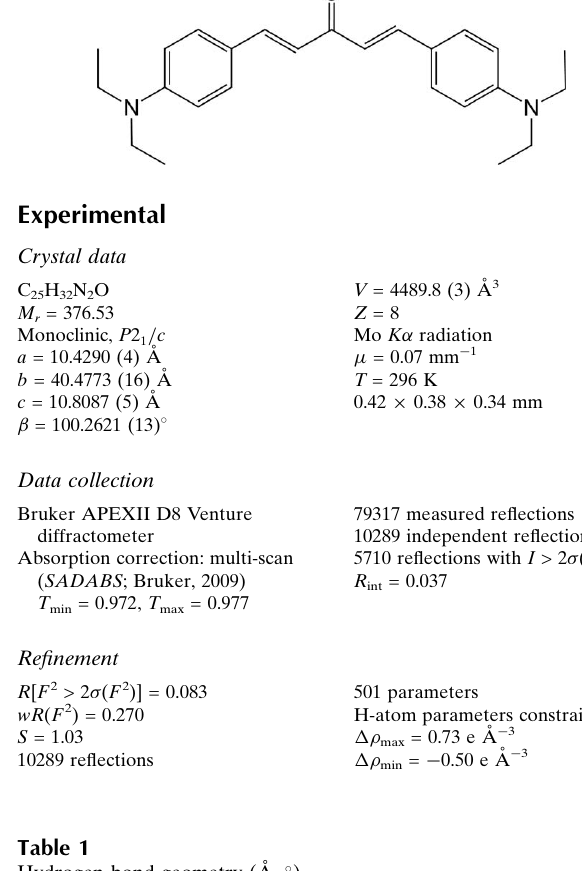
Hydrogen-bond geometry (A˚ , (cid:2) ). Cg 3 and Cg 4 are the centroids of the C1 B –C6 B and C12 B –C17 B rings,